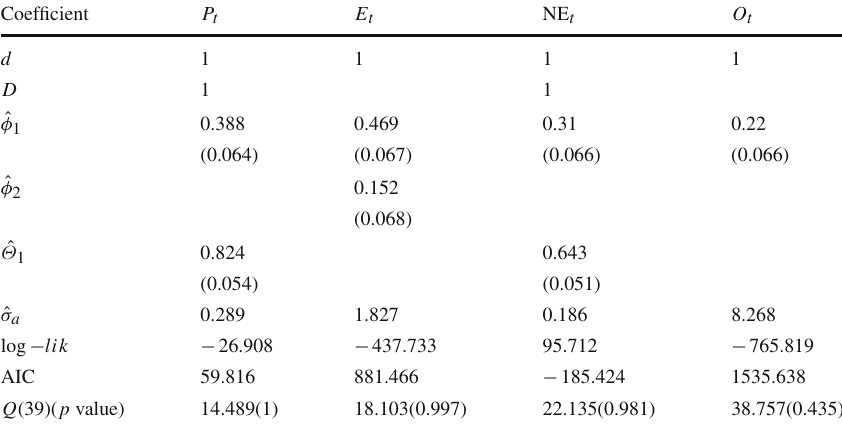
Table 3 Modeling results corresponding to the ARIMA ( 2 , 1 , 0 ) × ( 0 , 1 , 1 ) 12 process ( 1 − φ 1 L −